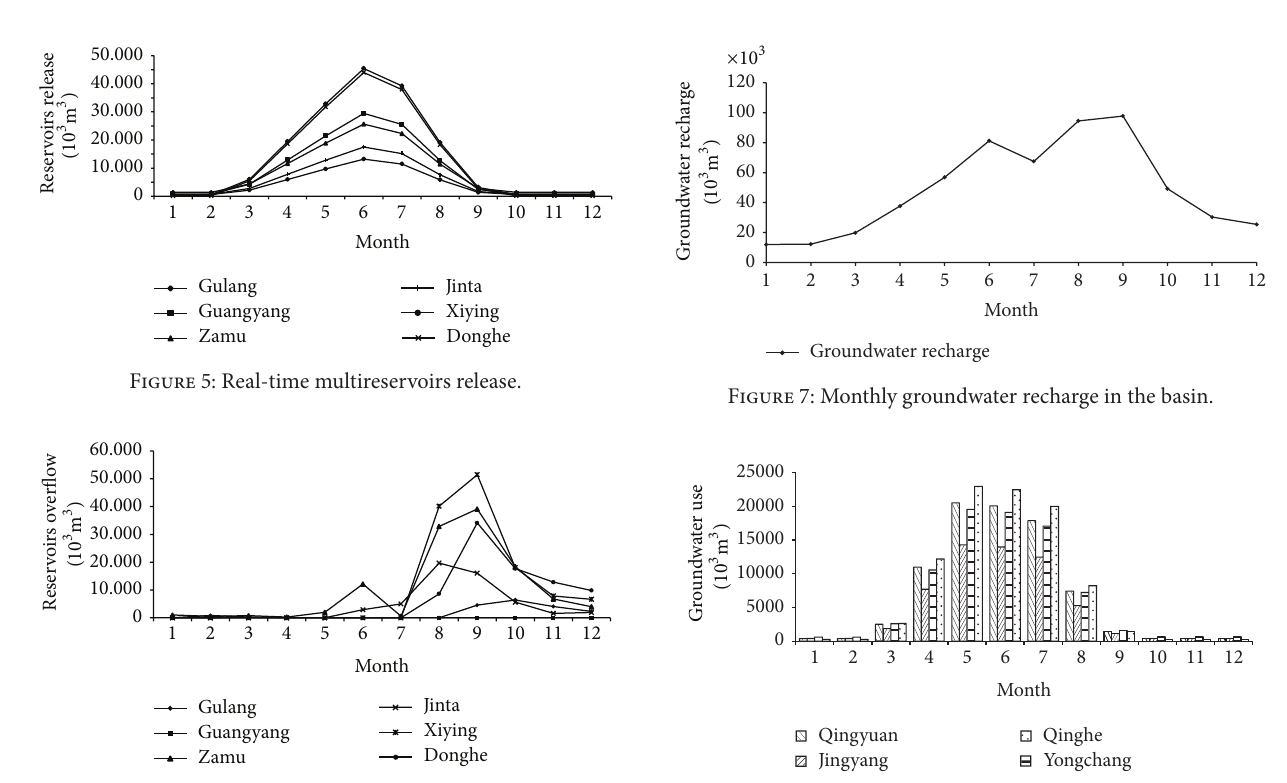
Figure 8: Monthly groundwater use in well irrigation